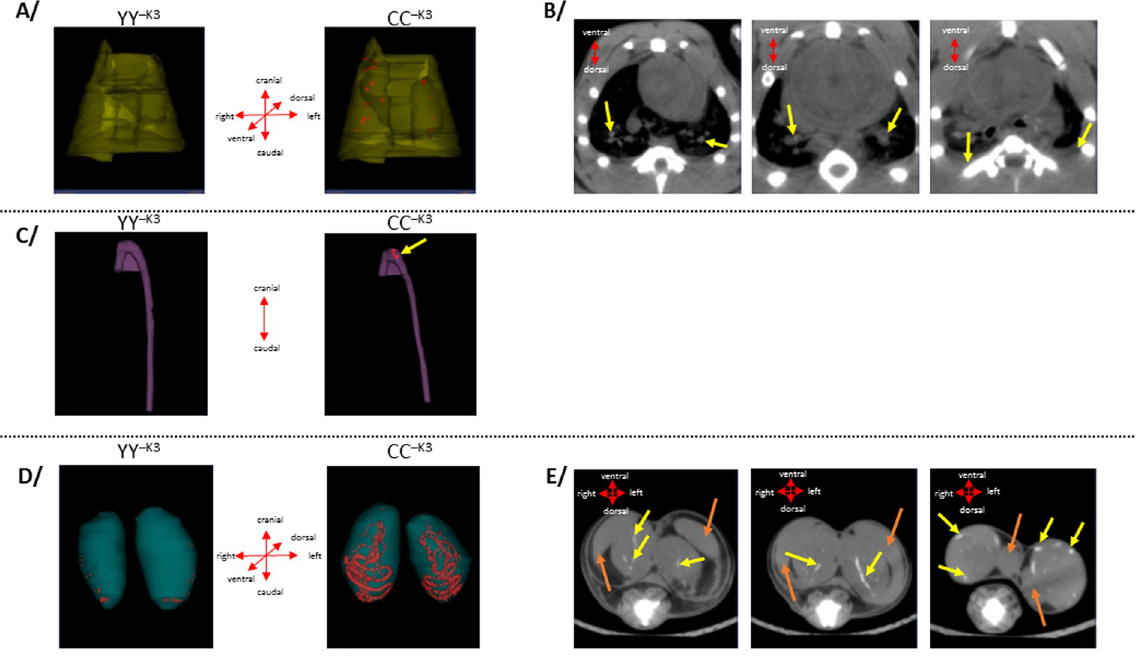
Figure 2. µ CT analysis of various tissues of YY − K3 and CC − K3 rats. In A /3D-representations of calcification volume (in red) inside lung (in yellow), in B /axial μ -CT views of calcifications present at the lung vessels of CC − K3 rats (calcifications are indicated by yellow arrows), in C /3D-representations of calcification volume (in red) inside aortic arch (in purple), in D /3D-representations of calcification volume (in red) inside testis (in grey), in E/axial μ -CT views of calcifications present in testis of CC − K3 rats (calcifications are indicated by yellow arrows and epididymis is indicated by orange arrows).